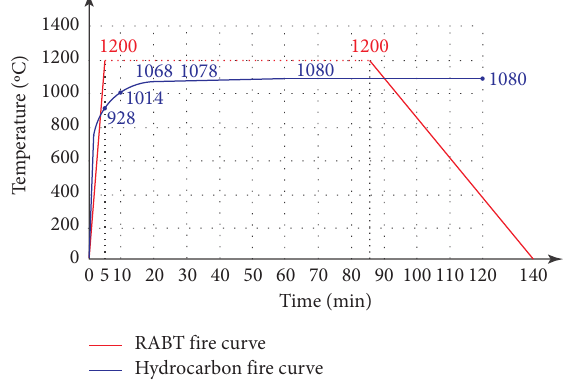
Figure 3: RABT and hydrocarbon fire standard heating